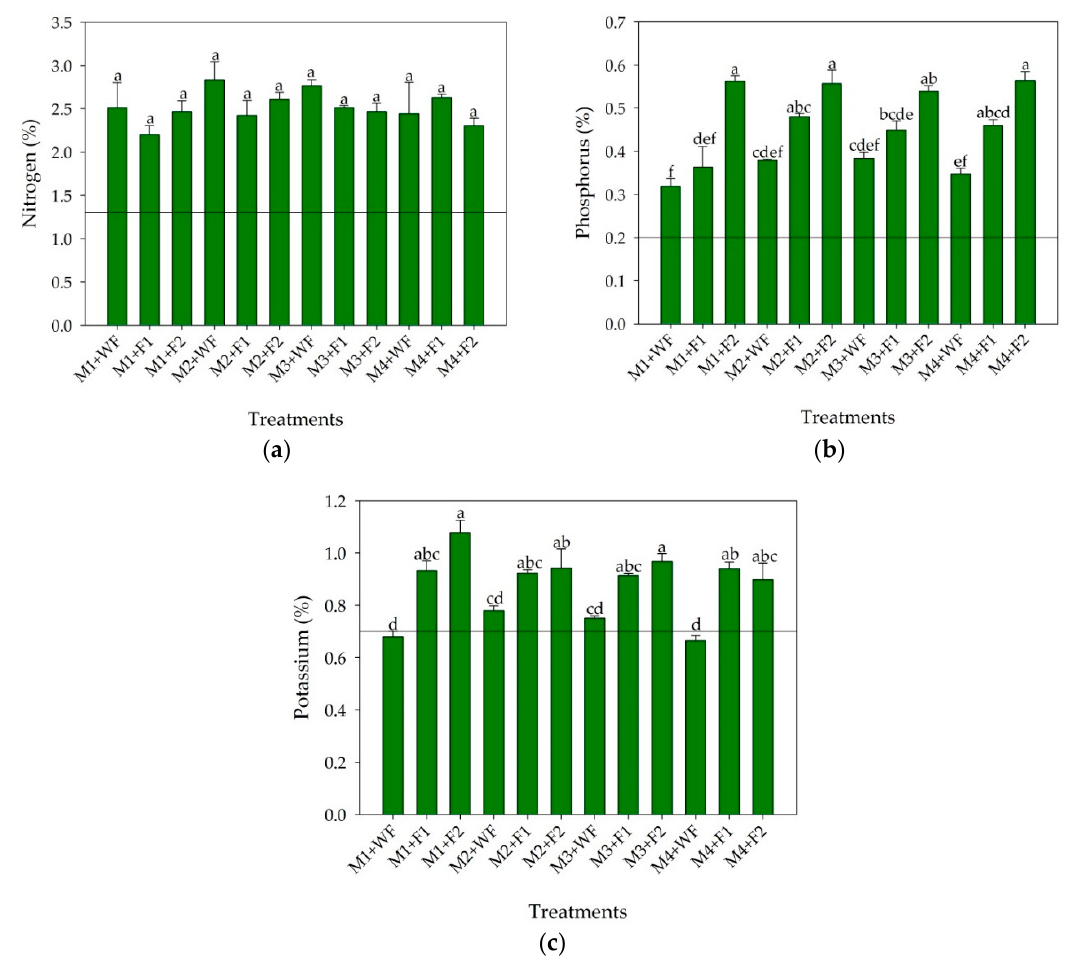
Figure 2. Fertilization settings in the foliage of Pinus cembroides Zucc. after 14 months under nursery conditions. Average concentration of: Nitrogen ( a ), Phosphorus ( b ) and Potassium ( c ). The horizontal lines indicate minimum values recommended for conifers [46].